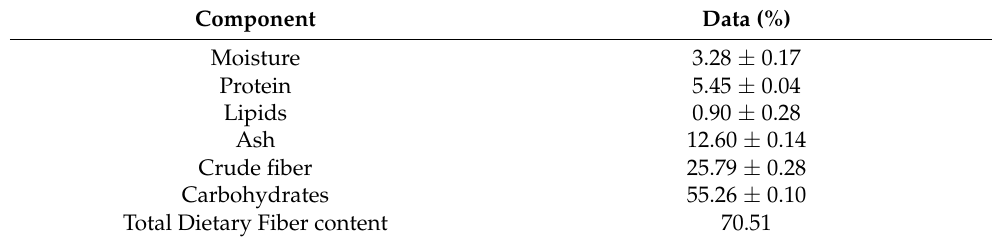
Table 1. Proximal composition of mucilage extracted from yellow pitahaya fruit